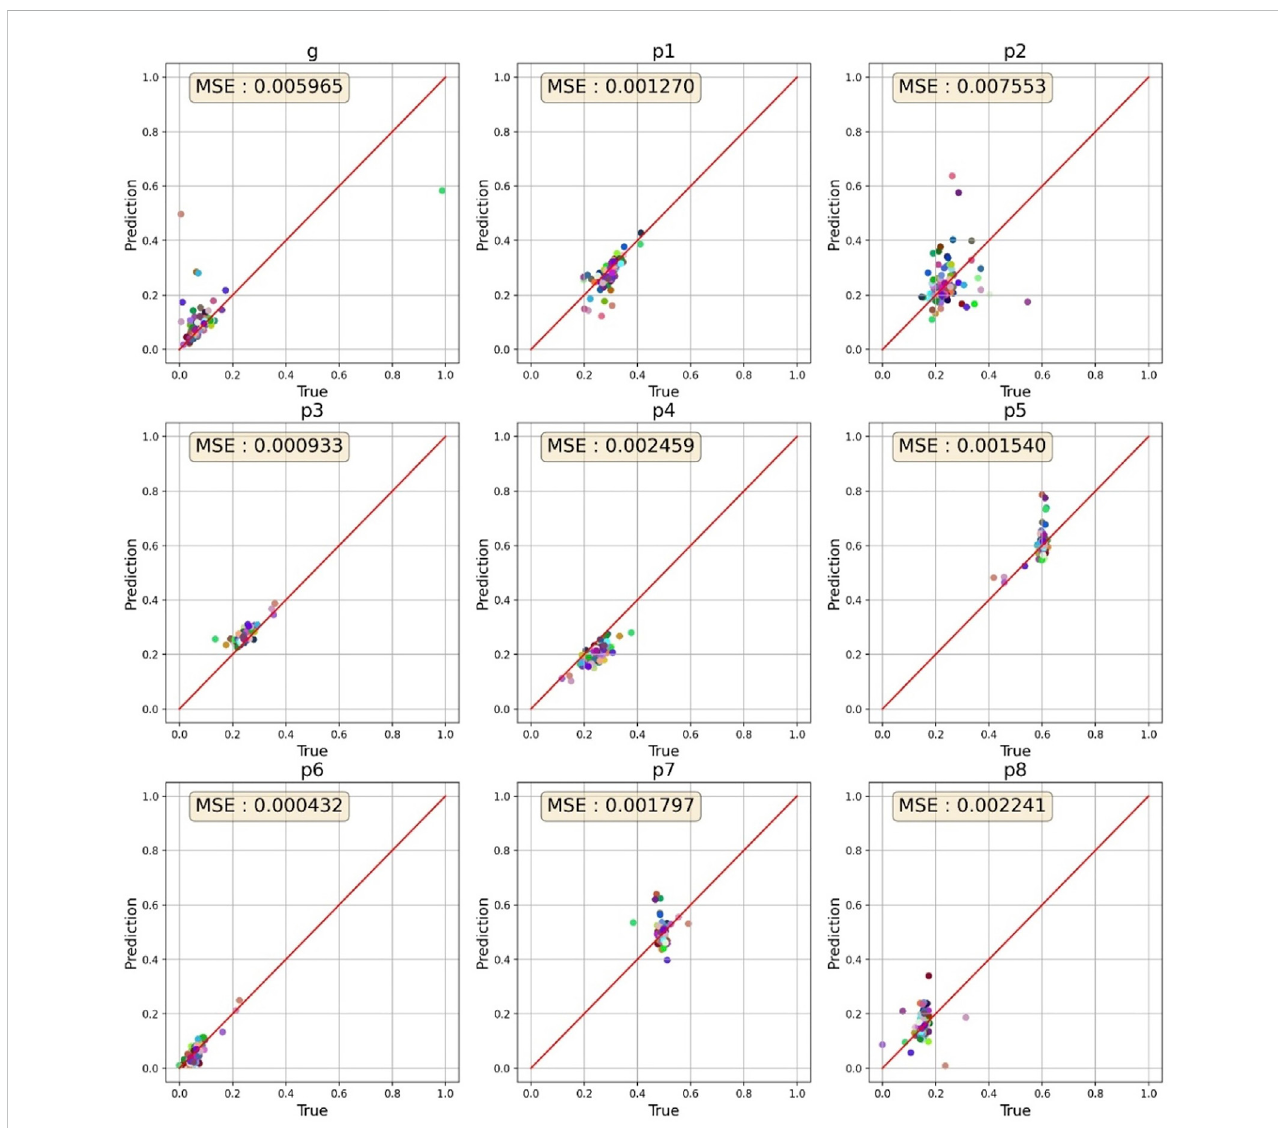
FIGURE 7 Prediction results for 100 cells. The parameters for most cells are clustered in a speci fi c range. p 6 had the best predictions, while p 2 had the worst predictions.